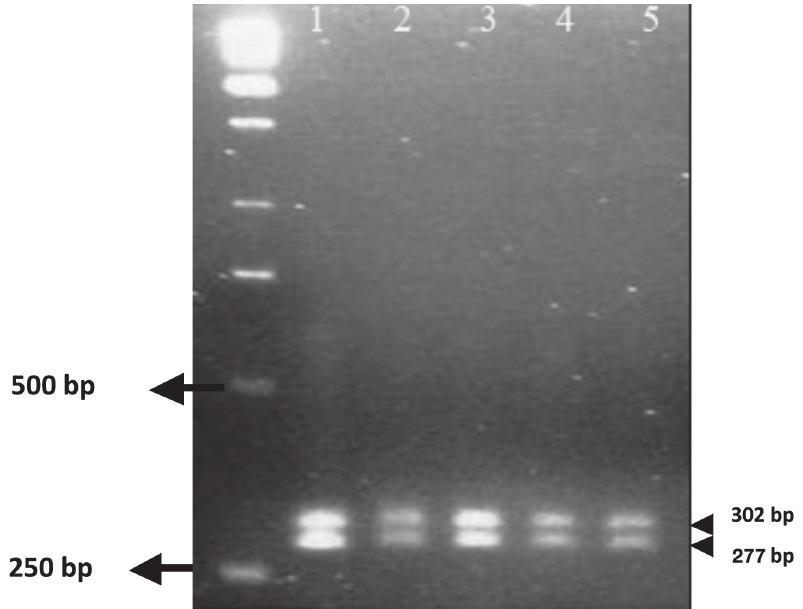
Figure 4. 3% Agarose gel electrophoresis of DNA amplicons obtained from TYLCV infected tomato samples using primers described by Accotto et al ., (2000), and digested with Ava II restriction enzyme: 1) Shoush, 2) Ramhormoz, 3) Behbahan, 4) Dezfoul, and 5) Shoushtar. M, 1Kb Ladder DNA marker